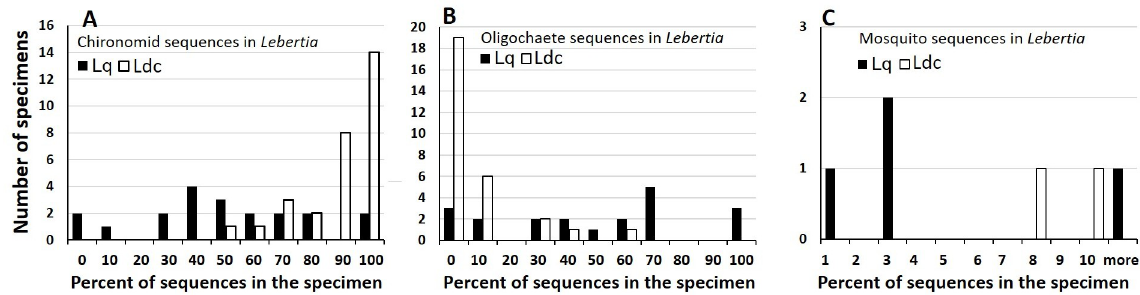
Fig 7. Histograms of frequency of percent abundances of sequences. (A) chironomid, (B) oligochaete, and (C) mosquito ( Culex pipiens ) OTUs in 20 L . quinquemaculosa (Lq, black bars) and 29 L . davidcooki (Ldc, white bars). The frequency of “no mosquito sequence” (bin “0”, not shown in (C)) was 16 L . quinquemaculosa and 27 L . davidcooki . Bins are 10% wide for A & B, 1% wide for C. Abundances are significantly different between L . quinquemaculosa and L . davidcooki for chironomids (p < 0.00001, Mann-Whitney U test) and oligochaetes (p < 0.00001, Mann-Whitney U test) but not mosquitoes (p > 0.05).